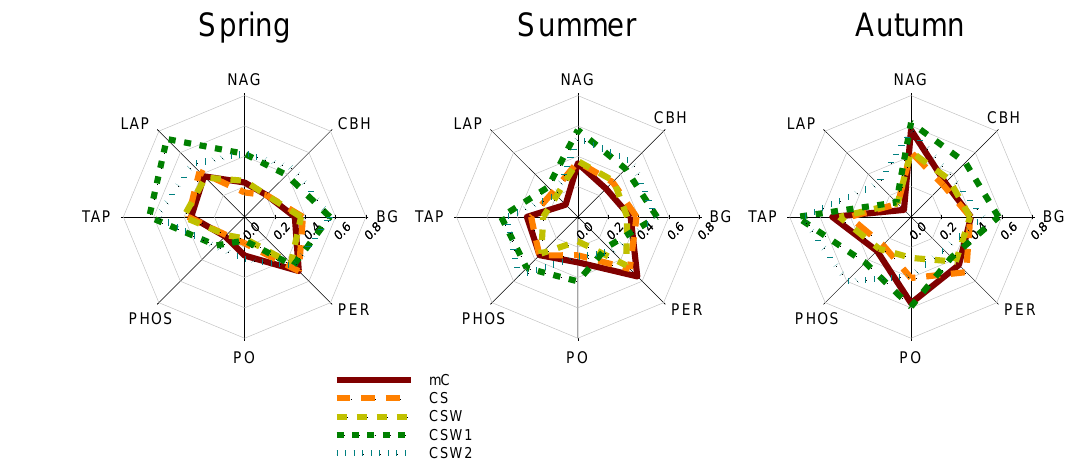
Figure 3. Mean extracellular enzyme activities (EEAs) normalized for the maximum value across all seasons. EEA abbreviations are β -1,4,-glucosidase (BG), β -D-1,4-cellobiohydrolase (CBH), β -1,4,-N-acetyl glucosaminidase (NAG), acid phosphatase (PHOS), tyrosine aminopeptidase (TAP), leucine aminopeptidase (LAP), phenol oxidase (PO), and peroxidase (PER). See Fig. 1 for crop rotation abbrevia- tions.